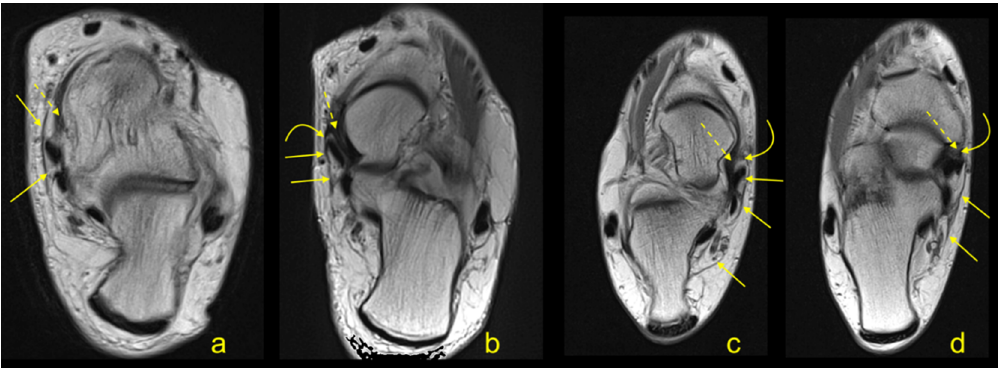
Figure 1. ( a , b )—a 55-year-old patient with clinical suspicion of tenosynovitis. ( c , d )—an 18-year-old patient with clinical suspicion of Achilles tendinopathy. ( a – d )—proton density (PD) weighted images. Flexor retinaculum (FR) (straight arrow) sends band (curved arrow) to joint with the tibionavicular part (TNP) (dashed arrow).